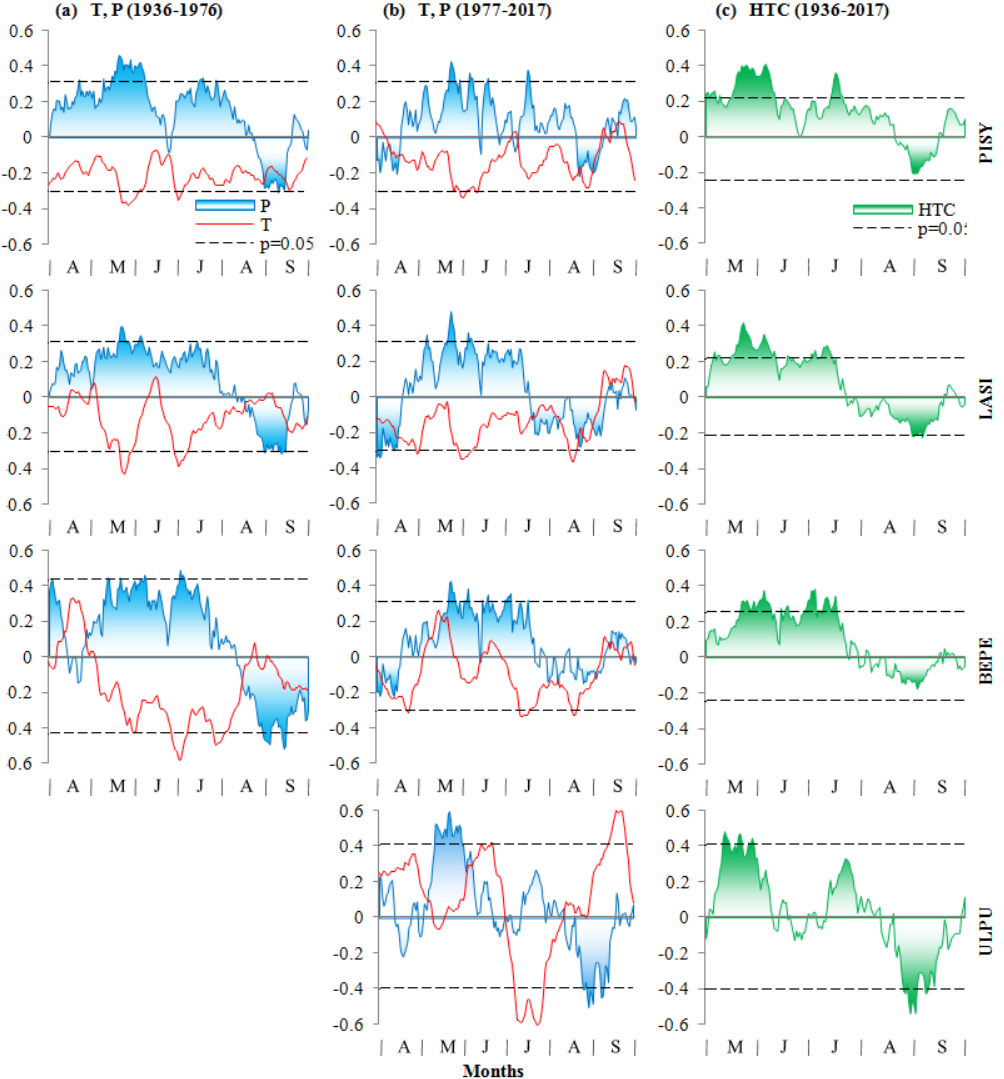
Figure 5. Correlation coe ffi cients between the TRW standard chronologies and the 21-day moving series of the climatic variables during April–September, namely: ( a ) temperature (lines) and precipitation (shaded areas) for the 1936–1976 sub-period; ( b ) the same plot for the 1977–2017 sub-period; ( c ) the hydrothermal coe ffi cient (shaded areas) for the entire 1936–2017 period. Dashed horizontal lines are thresholds for p =